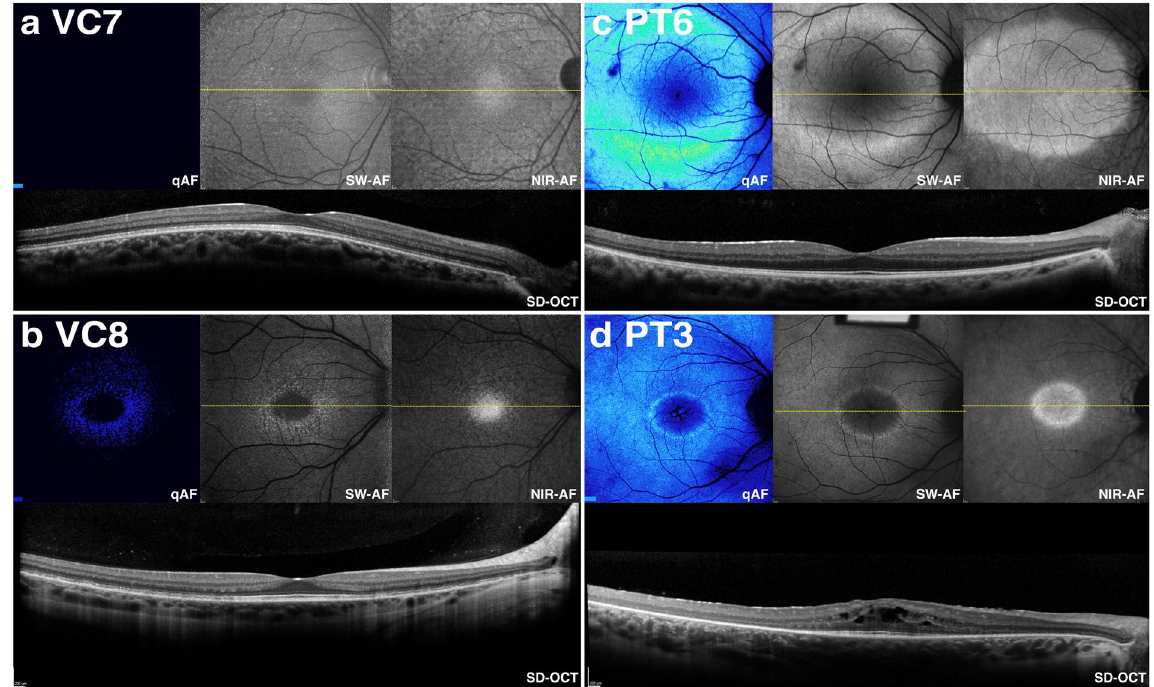
Figure 4. Comparison of color-coded quantitative fundus autofluorescence (qAF) with corresponding short- wavelength autofluorescence (SW-AF), near-infrared autofluorescence (NIR-AF), and spectral domain optical coherence tomographic (SD-OCT) images in patients carrying mutations in visual cycle (VC) ( a , b ; patients VC7 and VC8) or phototransduction (PT) ( c , d ; PT6 and PT3) genes. SD-OCT images indicate preserved outer retinal architecture as evidenced by lack of hypertransmission into the choroid. Note that qAF images have reduced AF signal in patients VC7 and VC8 as compared to patients PT6 and PT3.